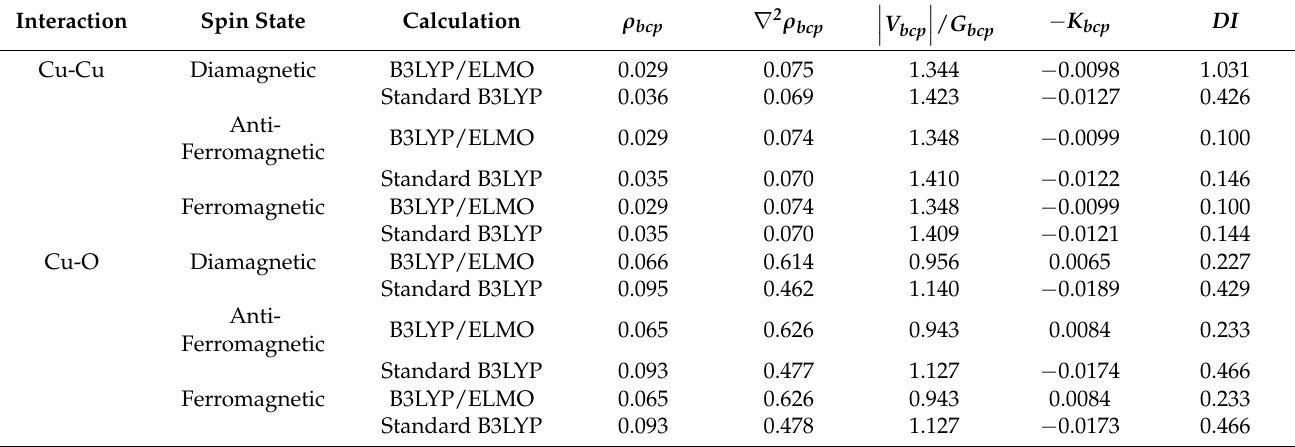
Table 1. Properties at the bond critical point between the Cu atoms and between the Cu and O atoms, as obtained from the calculations performed at different levels of theory with basis set 6-311G(2d,2p) on the model system extracted from the